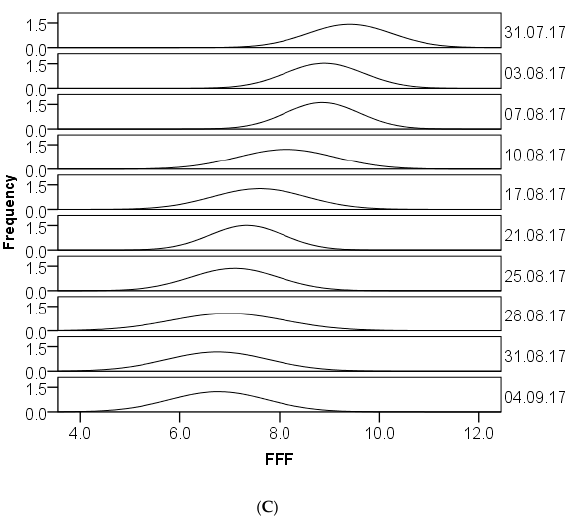
Figure 4. Sampling distribution during maturation (31 July to 4 September) of ( A ) IAD on the shaded fruit side and ( B ) starch pattern index (SPI 5), ( C ) fruit flesh firmness (FFF), of cv. ‘Gala Buckeye’ apples in 2017.